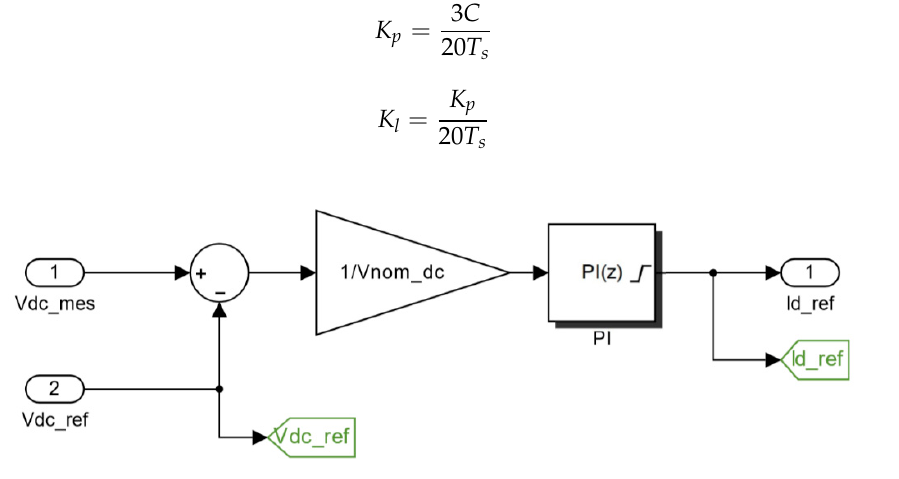
Figure 15. Input DC voltage regulator.